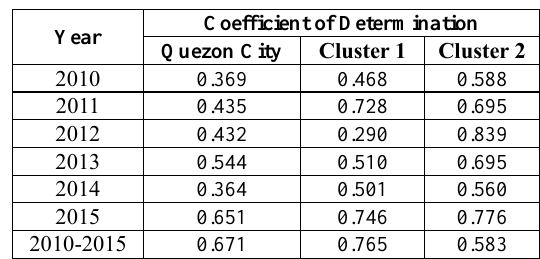
Table 8. Coefficient of determination from OLS regression for the whole Quezon City, Cluster 1 and Cluster 2 in each year and